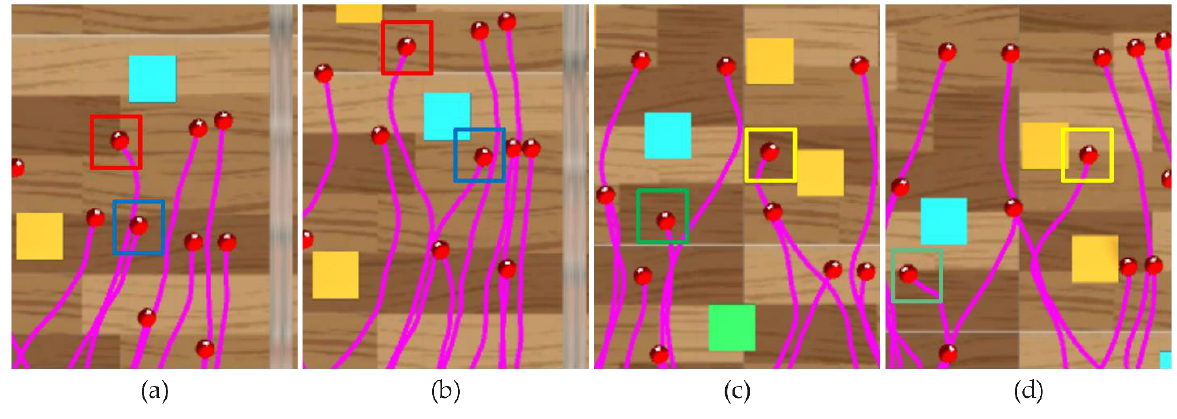
Figure 14. Collisions based on HDRLM3D. ( a – d ) Agents avoid collisions. Table 6. Performance comparison of the methods in the adjusted scenario